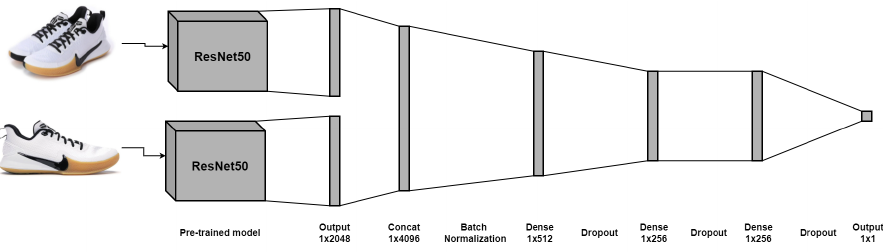
Figure 5. 2-CNN architecture for images of products.